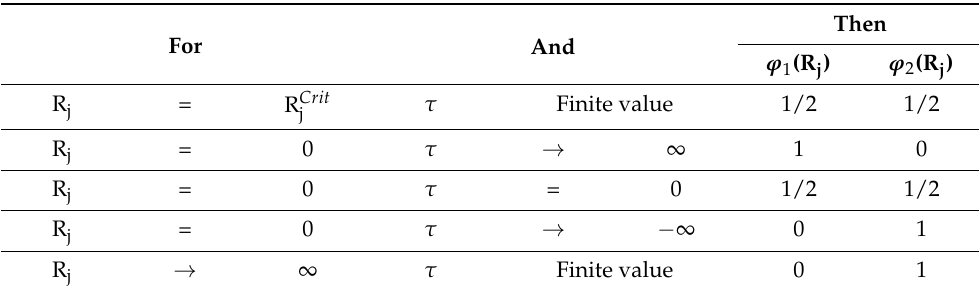
Table 2. Limiting behavior of ϕ 1 and ϕ 2 as a function of the independent variable R j and of the parameter τ